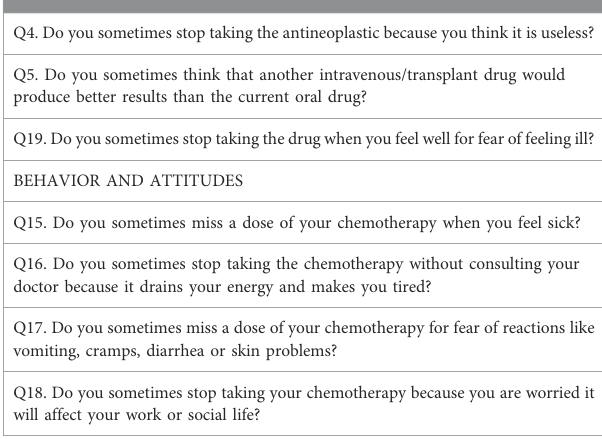
TABLE 3 McDonald ’ s omega ( ω ) coef fi cients. Item reliability statistics (if item dropped)